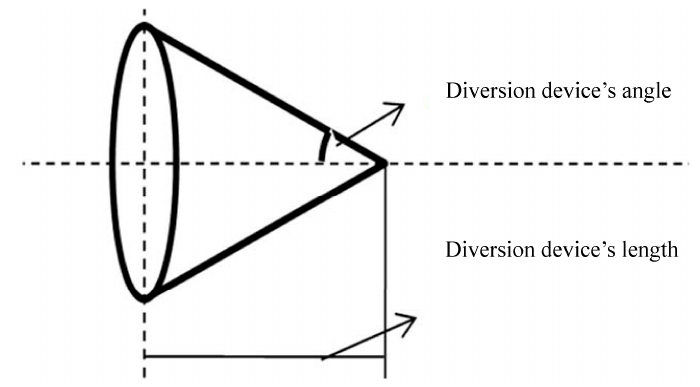
Figure 7. Diversion device’s structure.